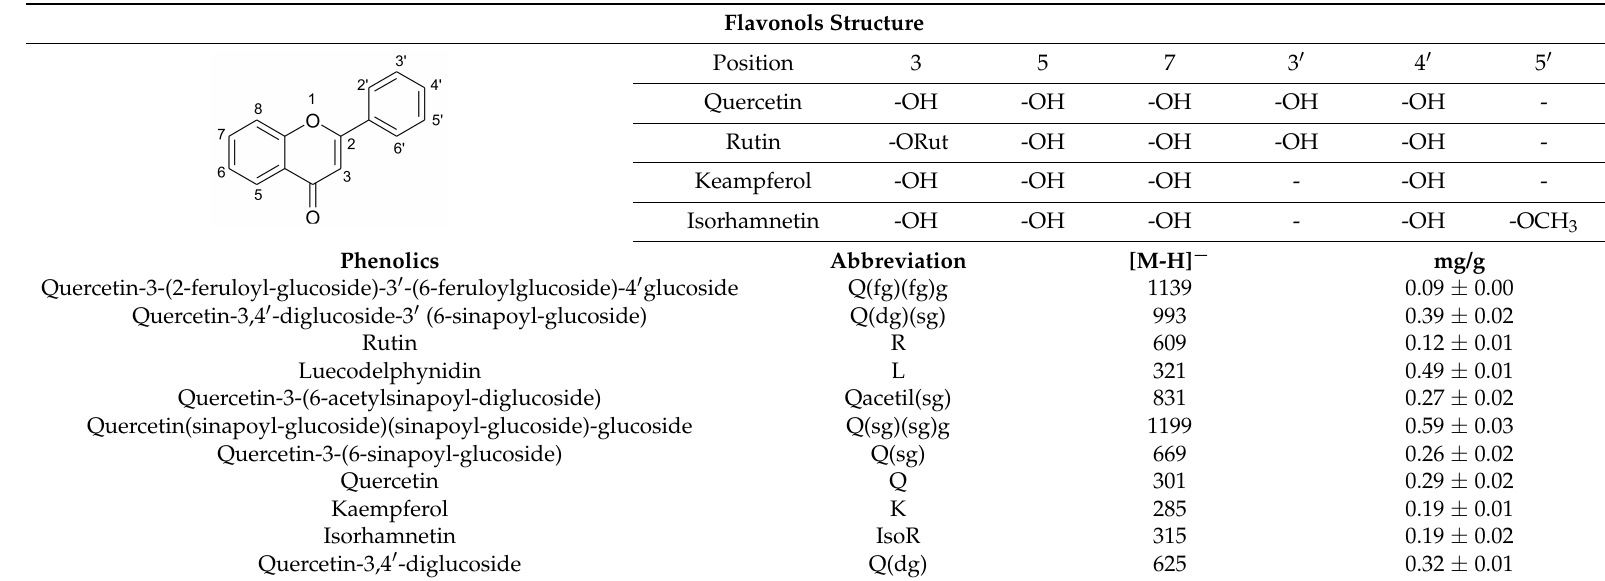
Table 2. Phenolics identified by LC/ESI-MS n in freeze-dried rocket leaves. ORut = O